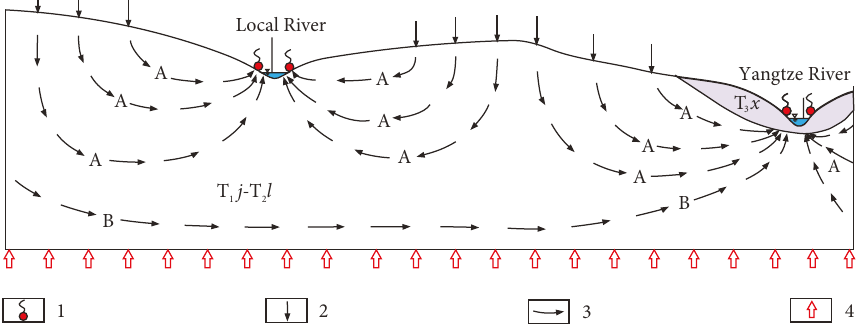
Figure 6: Conceptual pro fi le of circulation patterns of saline and salty springs along the fl ank of the anticline in the Sichuan Basin. 1: saline or salty spring; 2: precipitation in fi ltration; 3: groundwater fl ow direction; 4: heat fl ow; T j : Lower Triassic Jialingjiang Group; A: local groundwater fl ow system; B: regional groundwater fl ow system. Leokoupo Group; T 1